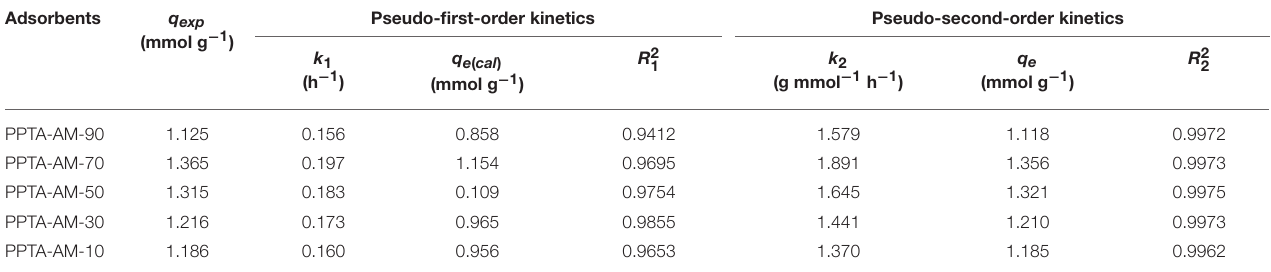
TABLE 4 | Langmuir and Freundlich isotherm constants for the adsorption of Hg(II) on PPTA-AM at 25 ◦ C (pH 5.0). Adsorbents Langmuir Freundlich Ratio of functional